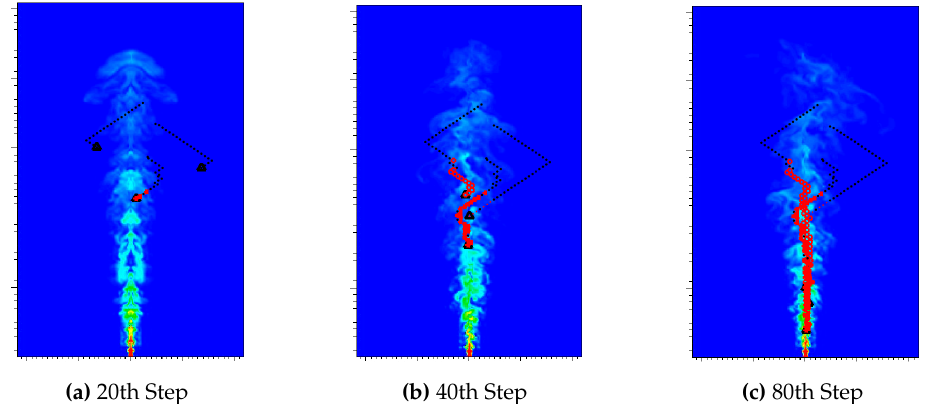
Figure 9. A team of three robots searching for the source of chemical dispersion (( a ) 20th Step; ( b ) 40th Step; ( c ) 80th Step). The red dots indicates the positive sensor readings. The 2D dispersion model used in this simulations is developed to simulate the 2010 Deep Water Horizon Oil Spill. The dimensions of the simulation arena is 748 × 322 units, and the maximum reach of the robot at each time step is 5 units at each direction. The probability field is spanned by 100 Gaussian functions. At each step of time, every robot propagates the event it experiences. The other robots calculate the value of information encapsulate in that event and decide whether or not they contribute that sensor event to its estimation.